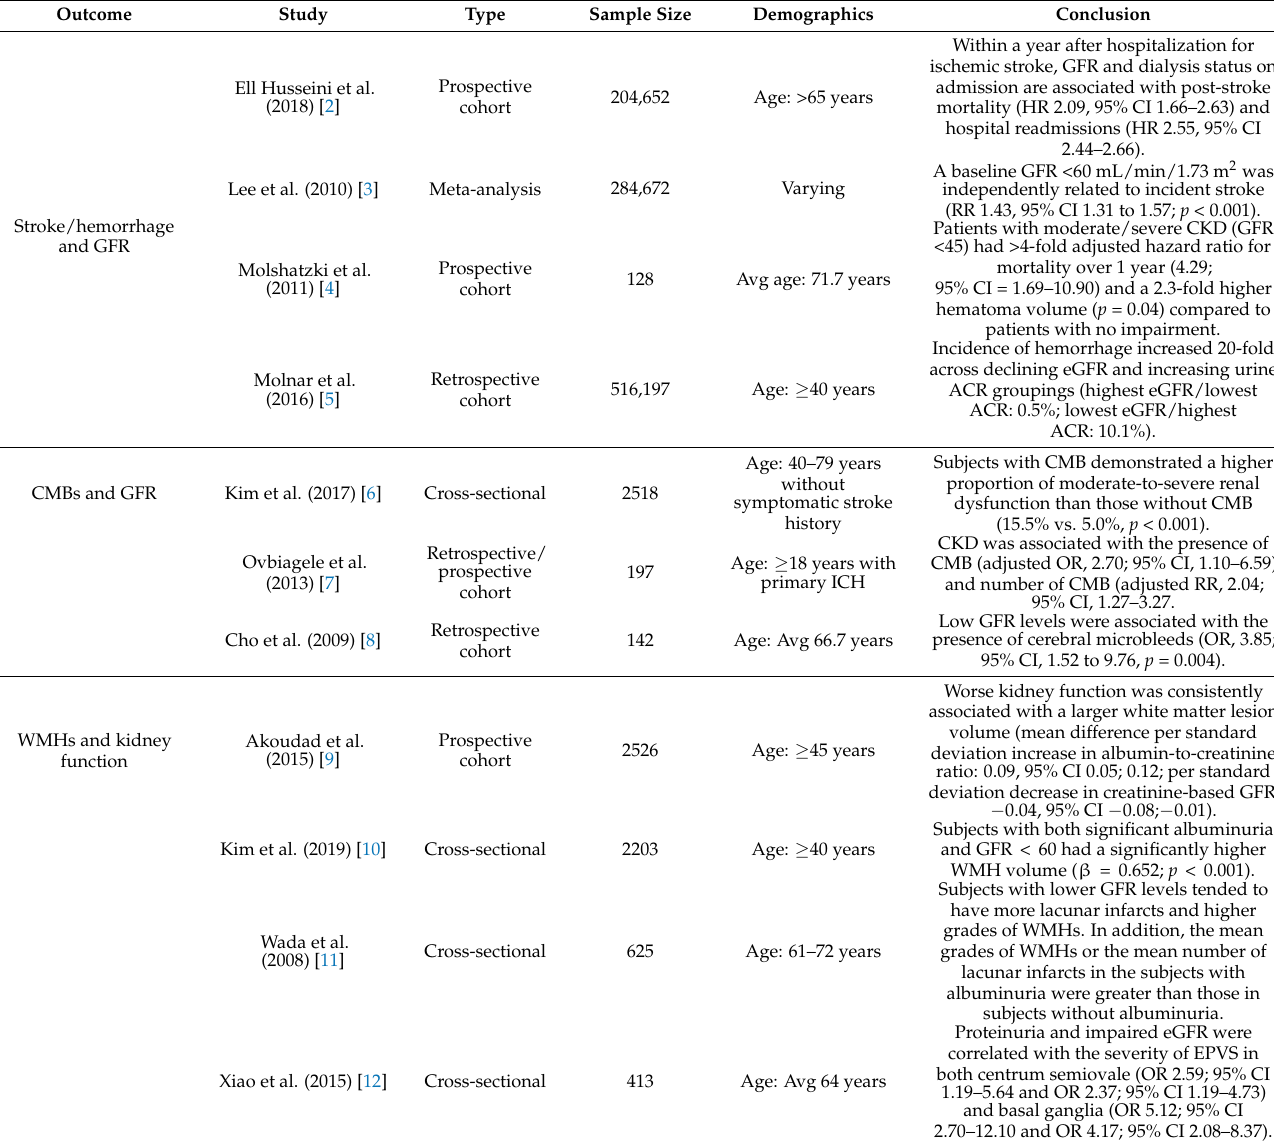
Table 1. Association of kidney function and cerebral vascular changes from population-based